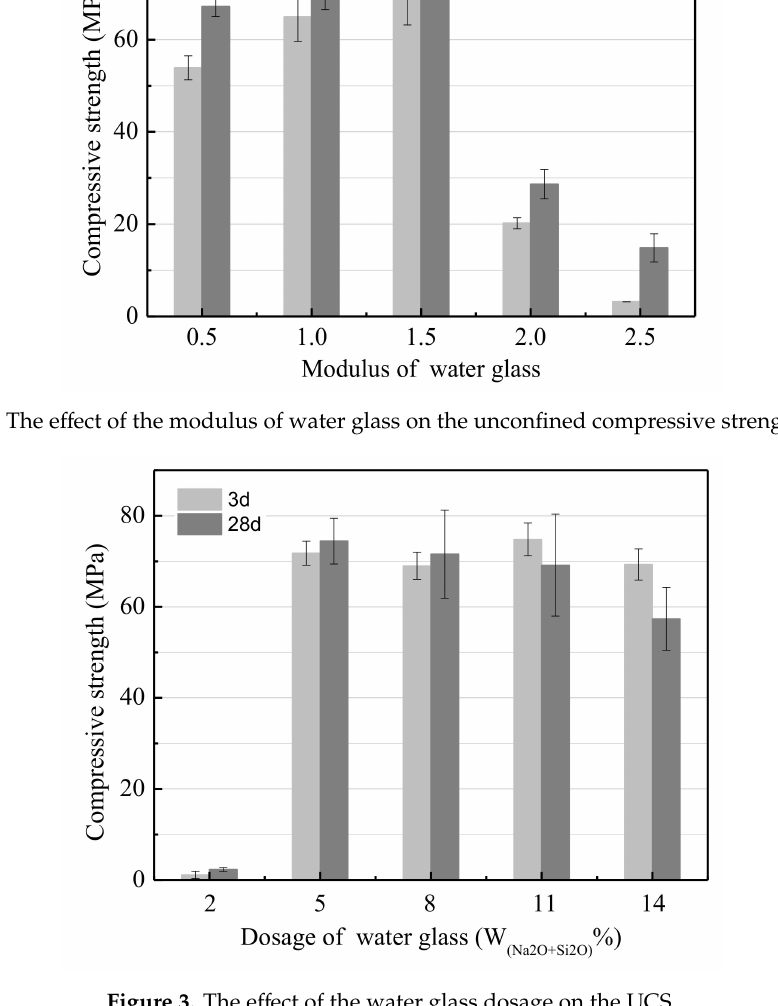
Figure 3. The e ff ect of the water glass dosage on the